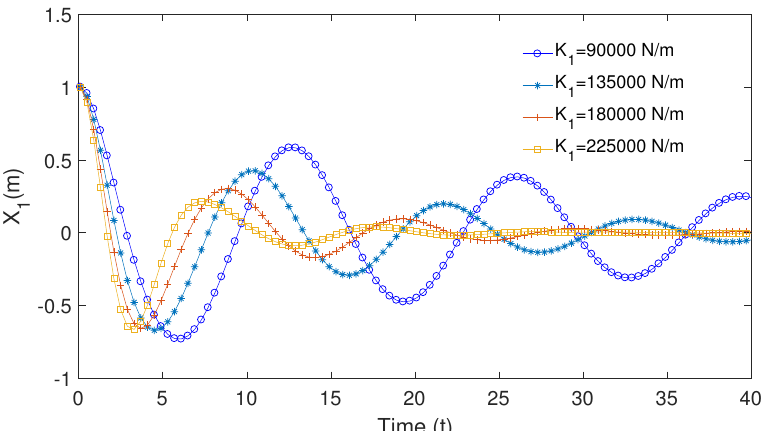
Figure 6. Surge decay test for cylinder with mooring line stiffness K 1 = 90,000 N/m, 135,000 N/m, 180,000 N/m and 225,000 N/m,